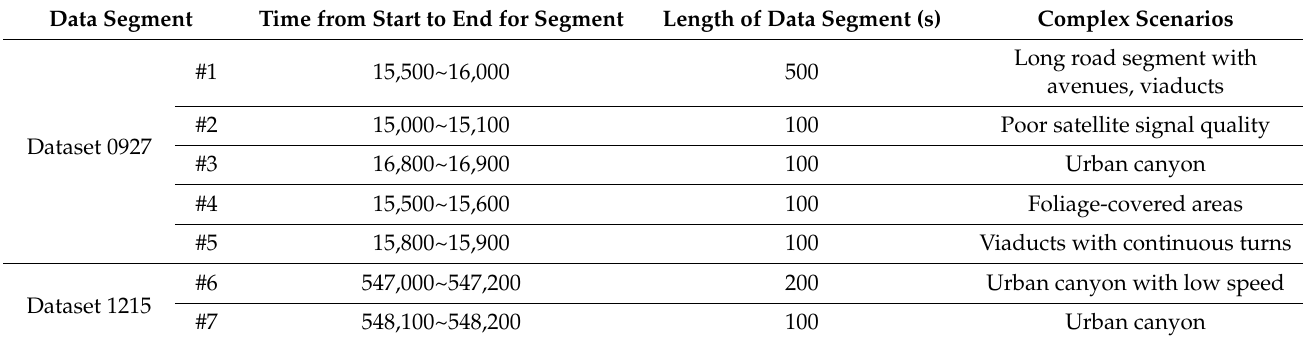
Table 2. Seven Data Segments of Complex Scenarios.